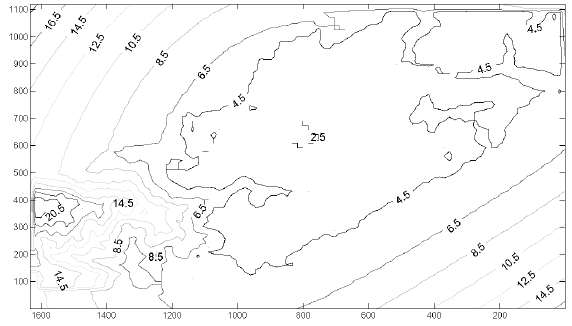
Figure 8. Results for Image 1 without bias compensation. Figure 9. Results for Image 1 with bias